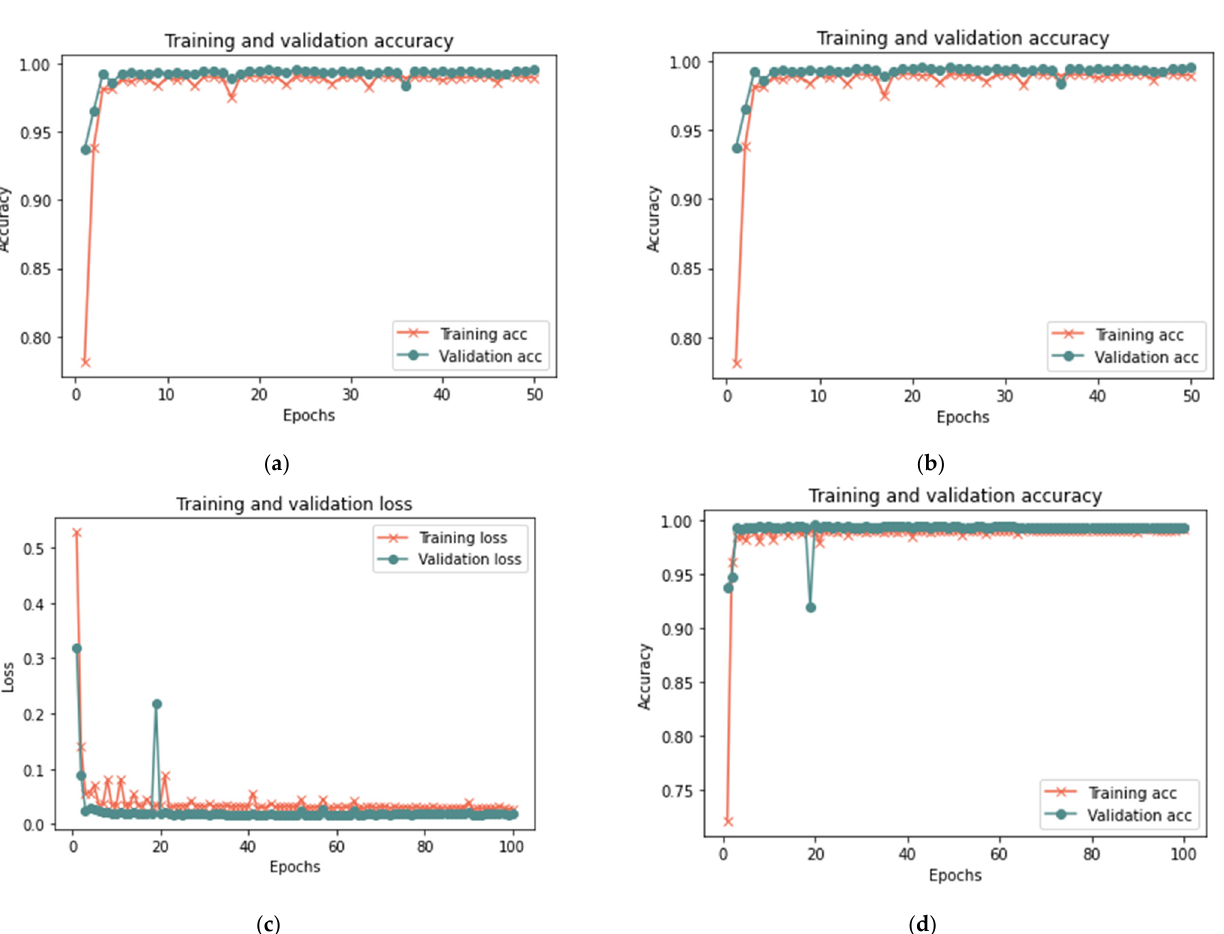
Figure 13. Results of the second scenario with a 25% sample size: ( a ) loss at 50 iterations; ( b ) accuracy at 50 iterations; ( c ) loss at 100 iterations; and ( d ) accuracy at 100 iterations.